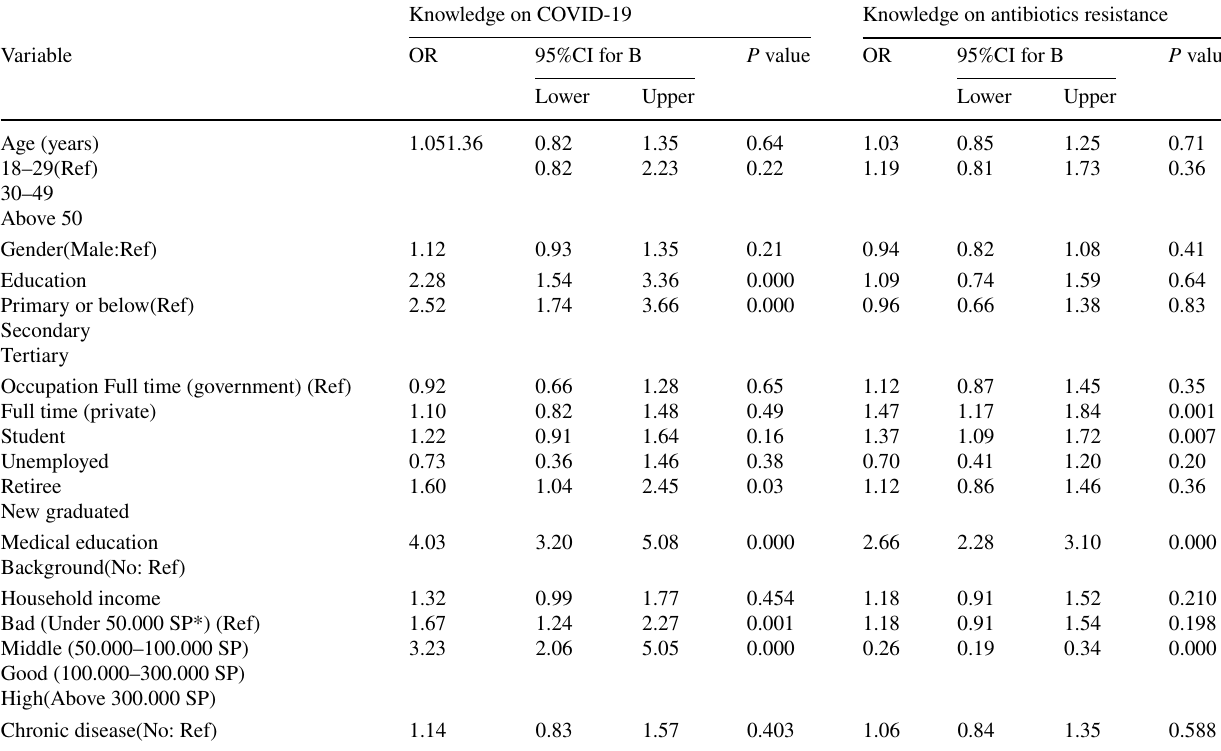
Table 5 Binary logistic regression between the scales that assesse knowledge towards COVID-19 and antibiotics resistance, and demographic characteristics